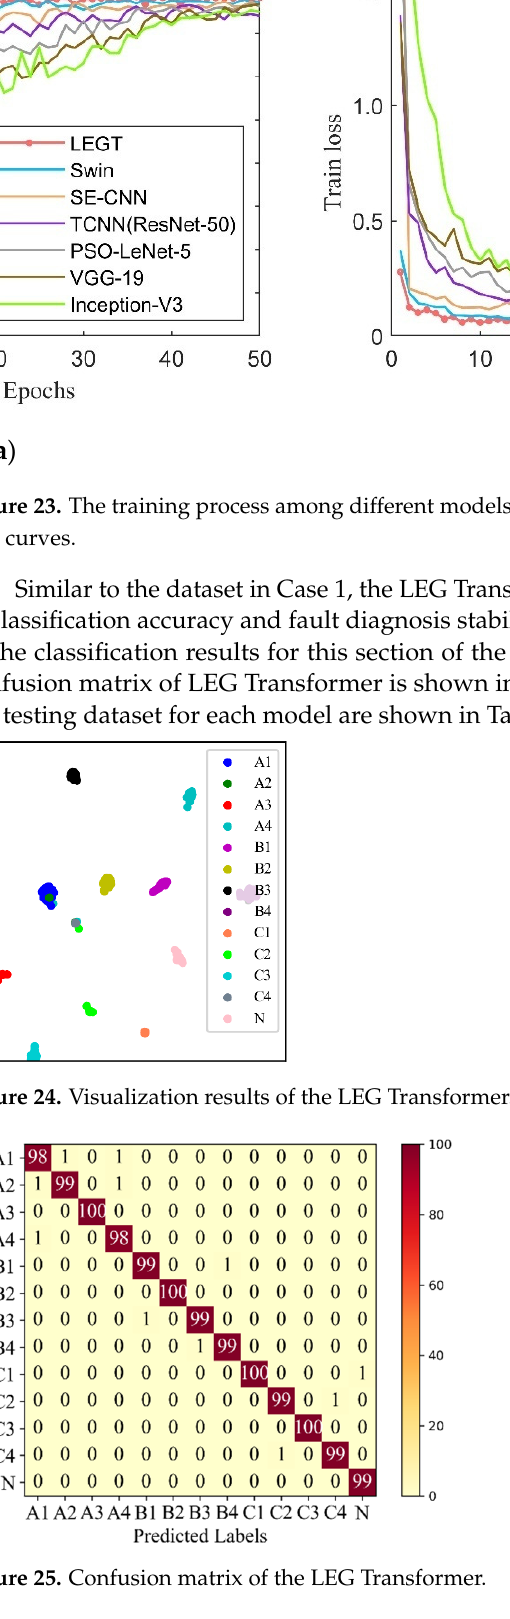
Figure 23. The training process among different models: (a) validation accuracy curves; (b) training loss curves.